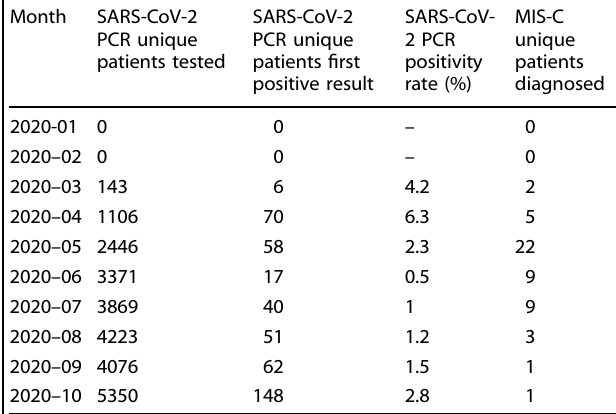
Table 1. Con fi rmed SARS-CoV-2 infections and MIS-C diagnoses.